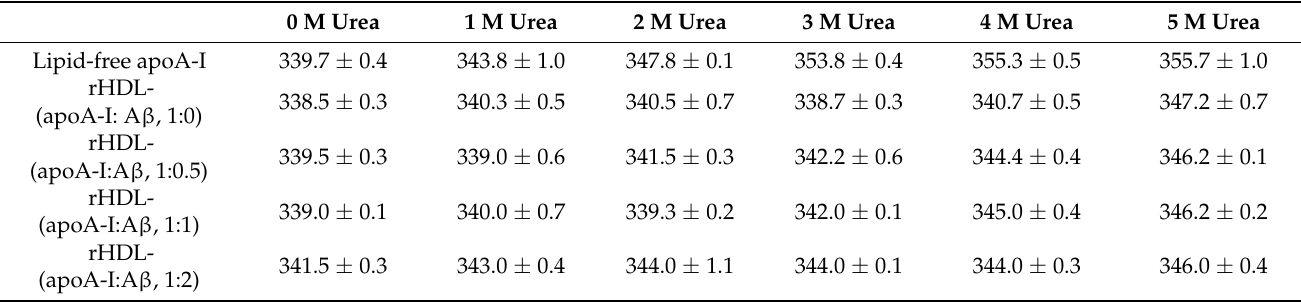
Table 2. Wavelength maximum fluorescence (Ex = 295 nm, Em = 310–400) of rHDL containing apoA-I and Ab in the presence of urea for isotheral